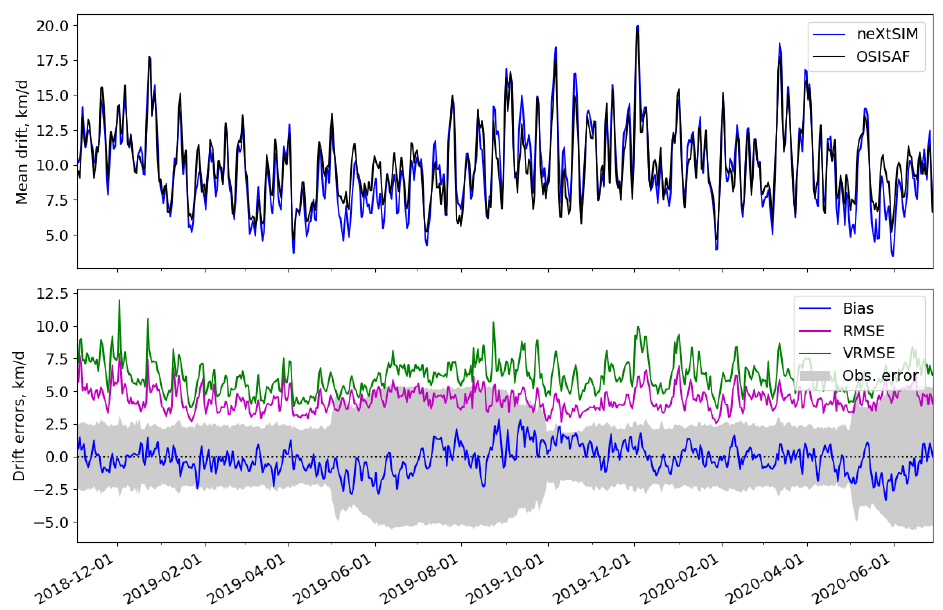
Figure 7. Temporal comparison of model and OSI SAF drift. The shaded region shows the rms uncertainty in the OSI SAF drift product. The bias is defined as the mean modelled speed minus observed speed. The mean drift and errors are averages over the regions where both model and observations have valid drift vectors. Valid observations here are those that have reported errors less than 10kmd − 1